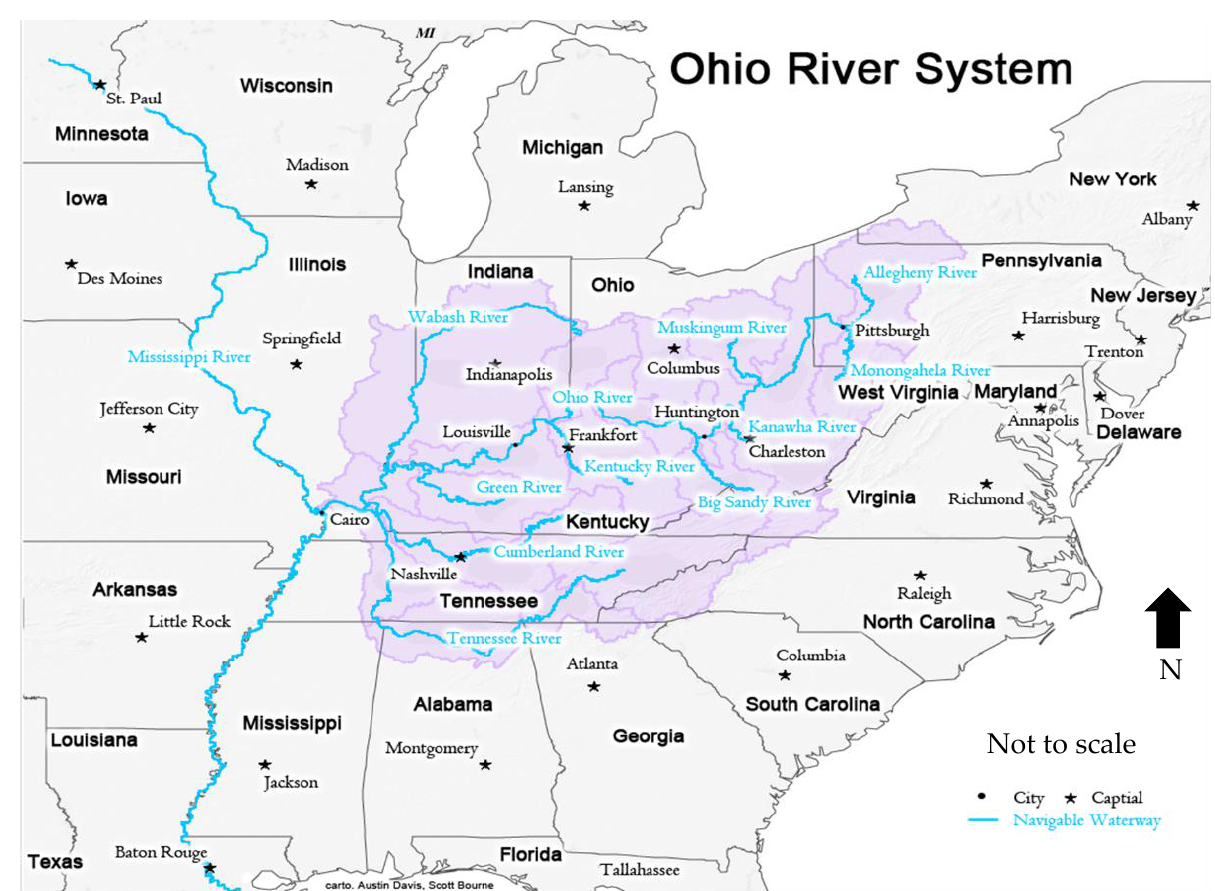
Figure 1. Ohio River System showing the location of the Cumberland River and Nashville, TN, USA [23].